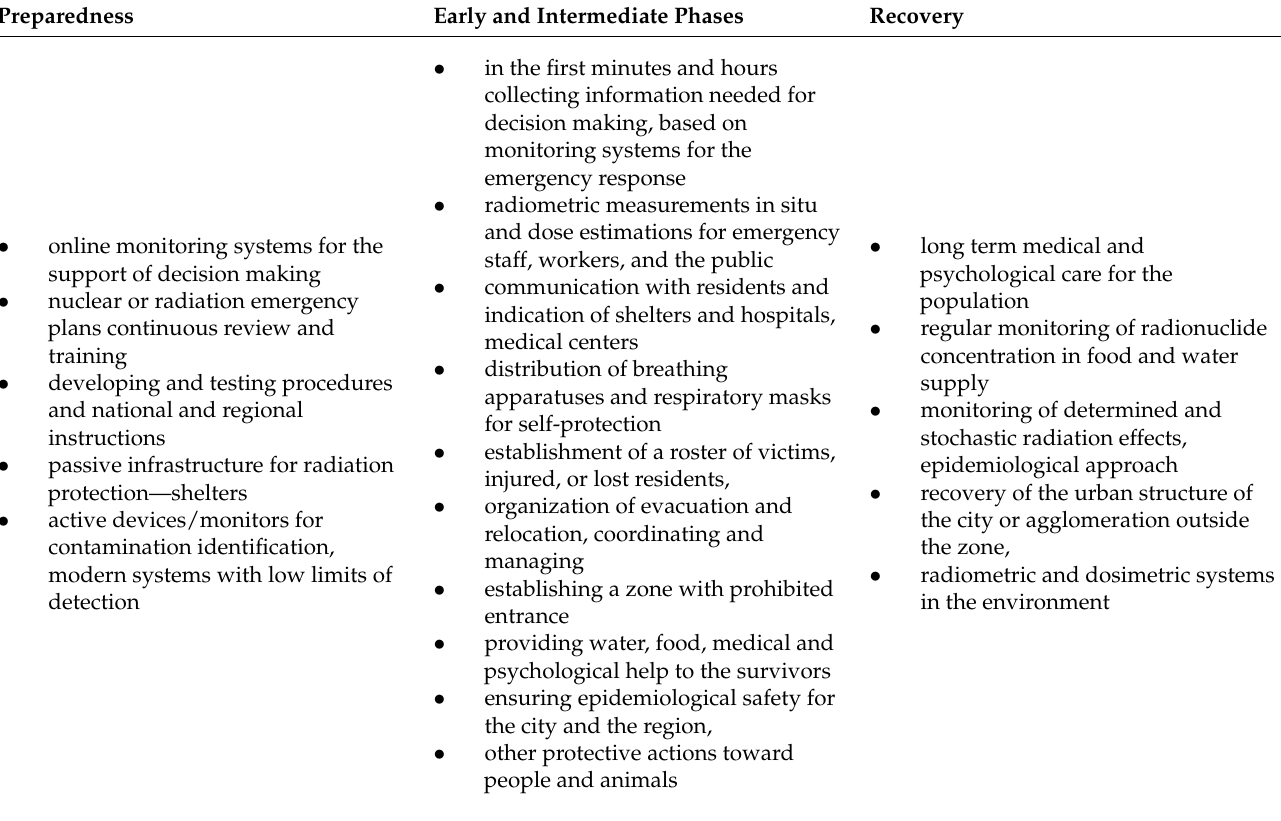
Figure 1. Exposure rate (biological effects) in phases before and after nuclear weapon use (illustrative diagram). Table 1. Phases and recommendations for the decision-making process.